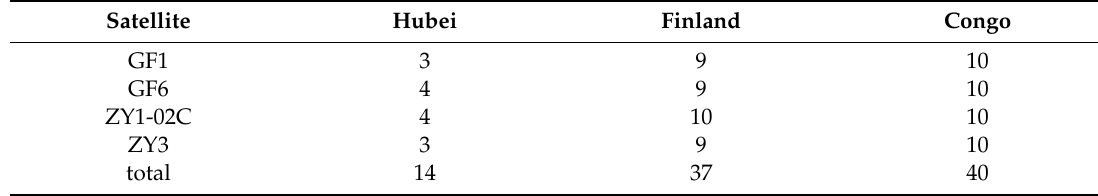
Table 3. Number of satellite transit